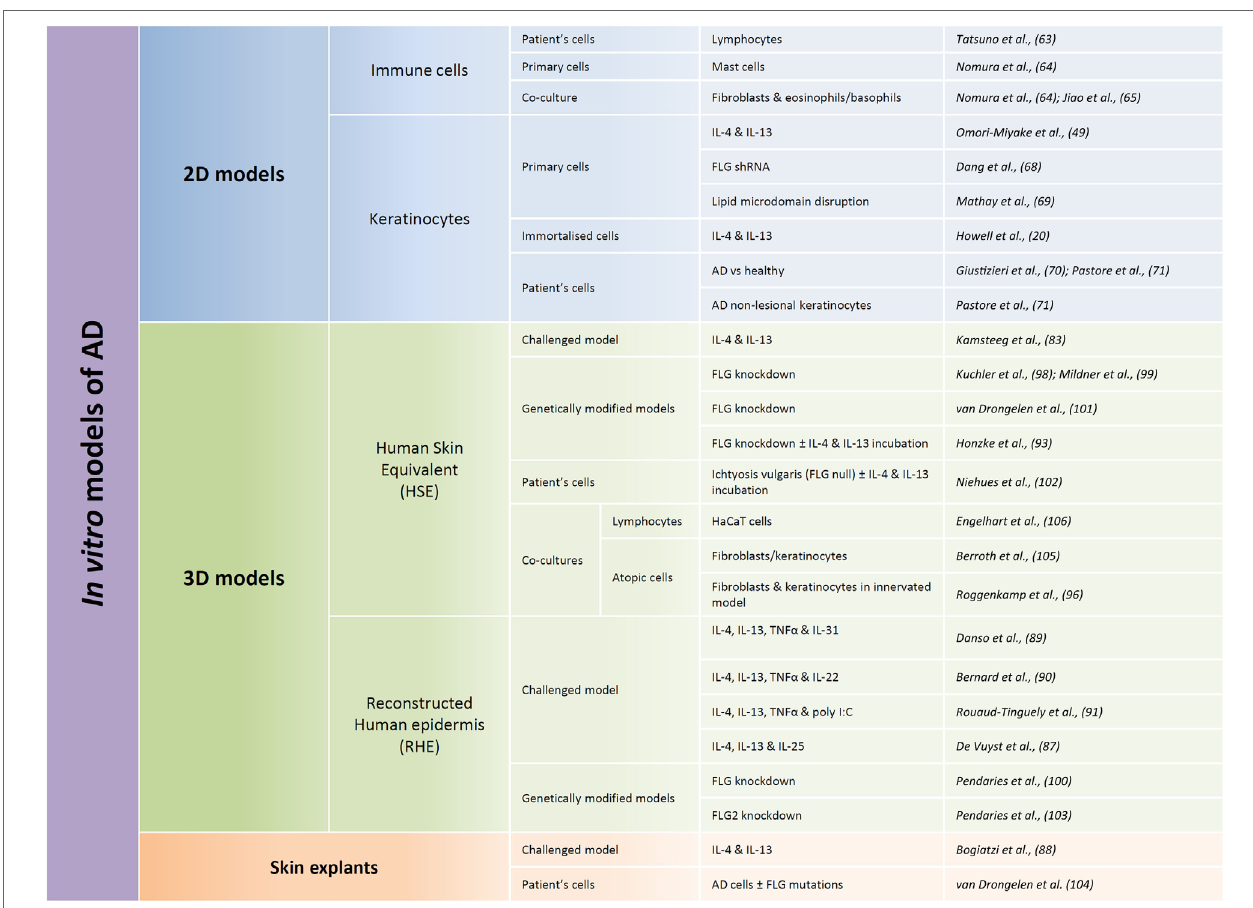
FiGURe 2 | Summary of published models developed for in vitro studies of atopic dermatitis (AD) features. Different types of in vitro models can be used in regards to the research focus, from the most simple ones consisting of only one cellular type (named here 2D models) to more complex models reconstituting the different layers of the epidermis (called here 3D models). 2D models are used in order to characterize behavior of one given cellular type whereas 3D models are more commonly used with the aim of trying to reproduce some features of the pathology. Within these two types of models, immortalized cells can be used, but in order to be closer to the in vivo situation, primary cells are often used. Cells derived directly from patients are probably the most relevant but also the more complicated to obtain and the most limited. While performing 3D models, two different types of models are commonly used: human skin equivalents (HSE) or reconstructed human epidermis (RHE). HSE reproduce the epidermis on top of a dermis equivalent, whereas RHE only reproduce the different layers of the epidermis. HSE are more complicated to produce but display the advantage to present a dermal compartment whereas RHE allow evaluation of keratinocyte-specific type of responses and analysis of released or secreted molecules in the culture medium. HSE or RHE can both be challenged by interleukin cocktails and genetically modified. And cocultures with immune cells could be performed in both